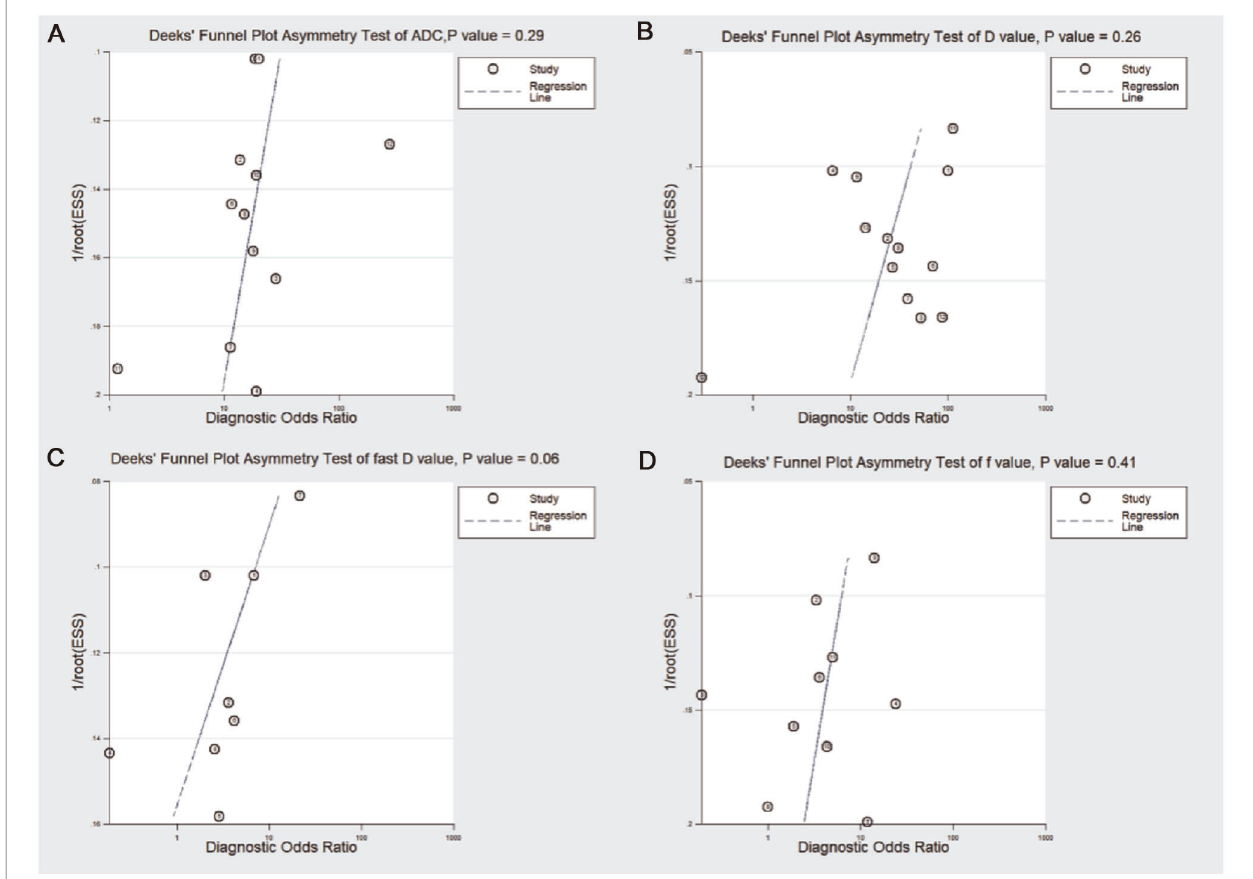
FIGURE 8 | Deeks ’ funnel plots regarding the diagnostic performance for the ( A ) apparent diffusion coef fi cient (ADC value); ( B ) tissue diffusivity ( D value); ( C ) pseudo- diffusivity ( D * value); and ( D ) perfusion fraction ( f